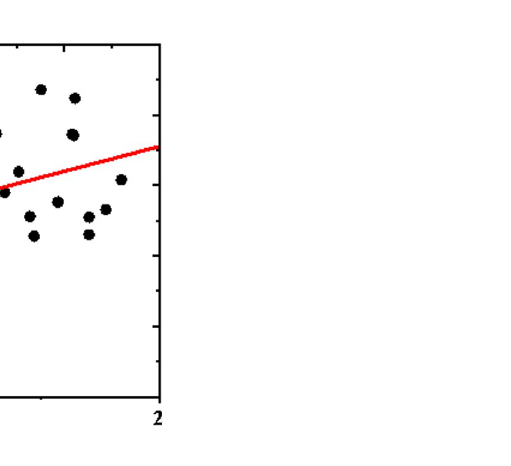
Fig 6. Correlation between VABG and infarct